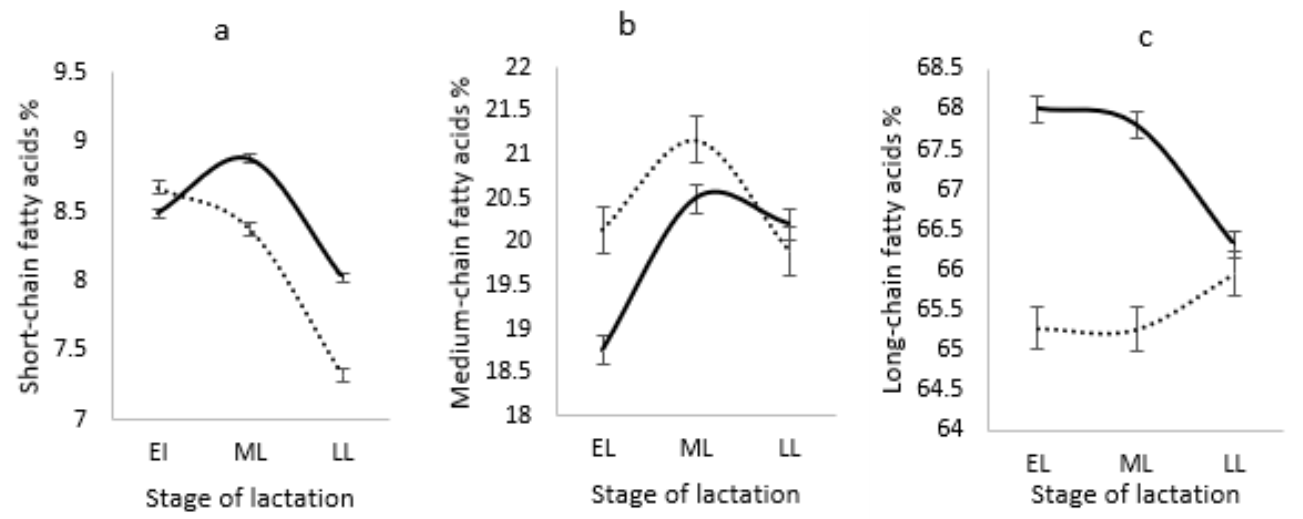
lactation (<90 days); ML = mid lactation (90–180 days); LL = late lactation (>180 days). The vertical bars show the standard errors. The p -values for the interaction between milking frequency and stage of lactation were <0.0001 for saturated, unsaturated, and polyunsaturated fatty acids.